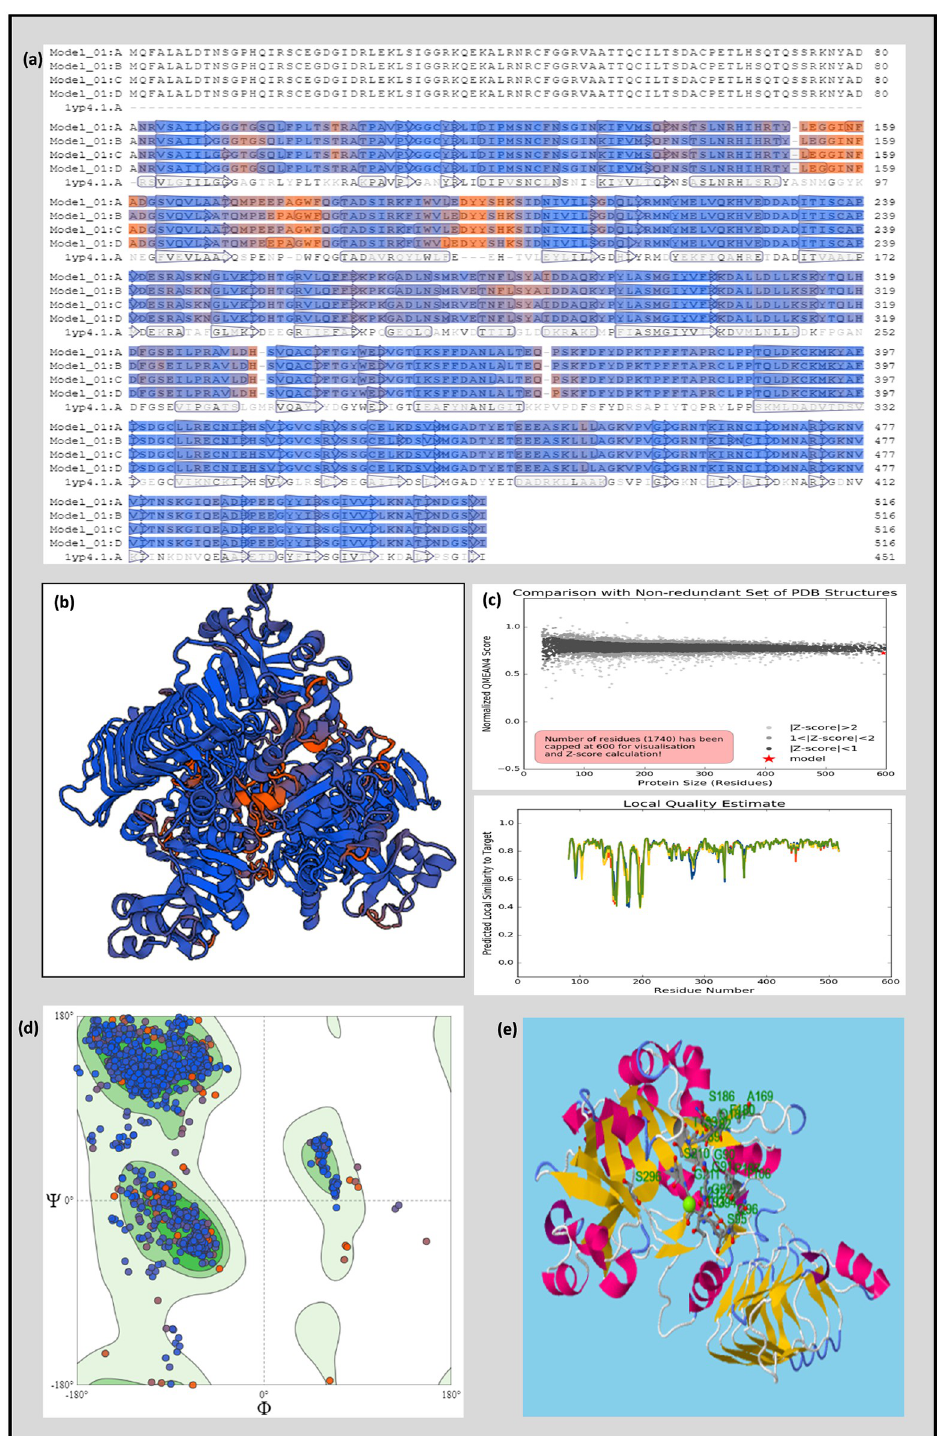
Fig 6. Homology-based protein model of large subunit of AGPase; (a) alignment with similar templates; (b) protein model generated using SWISS-MODEL; (c) comparison with non-redundant set of PDB structures and Local quality estimate; (d) Ramachandran Plot and (e) Ligand-binding sites predicted using RaptorX.